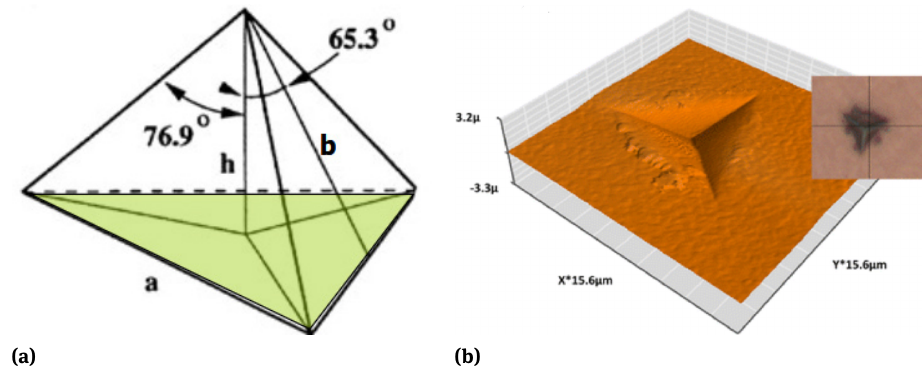
Figure 1: Geometry of Berkovich indenter